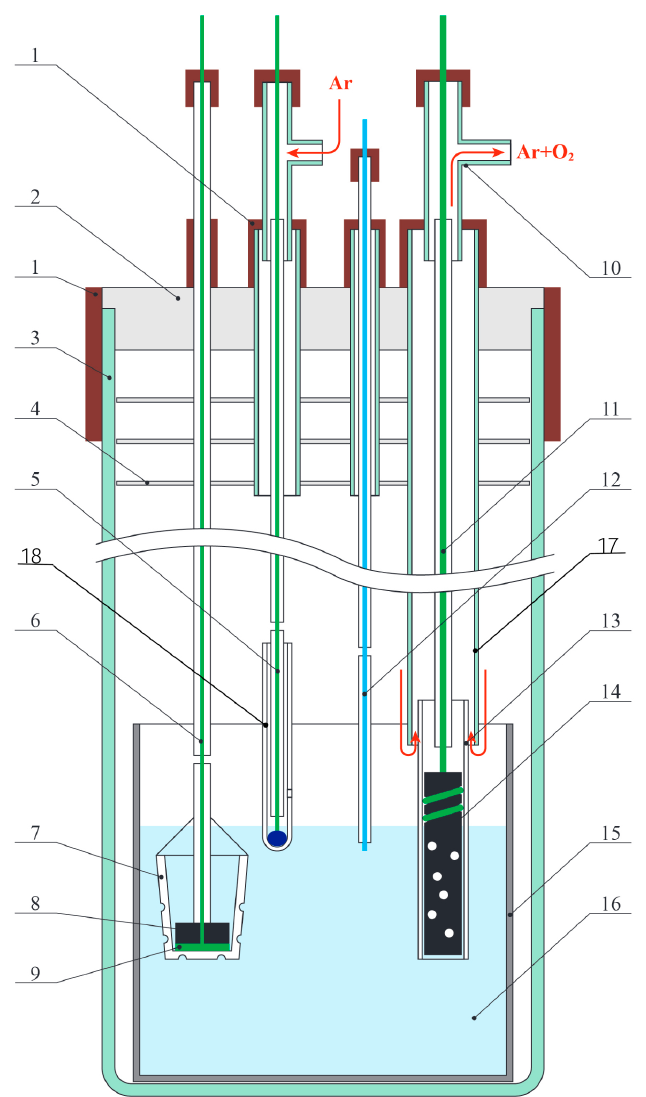
Figure 1. Schematic of the laboratory electrolytic cell: 1 —silicon rubber seals; 2 —fluoroplastic cover; 3 —electrolytic cell body; 4 —thermal screen; 5 —Bi-Li reference electrode; 6 —Mo current lead; 7 —MgO ceramic crucible; 8 —REM oxide pellet; 9 —Mo wire cathode; 10 —T-shaped glass pipe; 11 —Pt current lead to the anode; 12 —auxiliary Mo electrode; 13 —ceramic MgO tube, which covers the anode; 14 —NiO-Li 2 O (glassy carbon) anode; 15 —metallic (stainless steel or nickel) or MgO ceramic container for the electrolyte; 16 —LiCl-Li 2 O electrolyte; 17 —quartz glass tube; 18 —MgO ceramic tube.